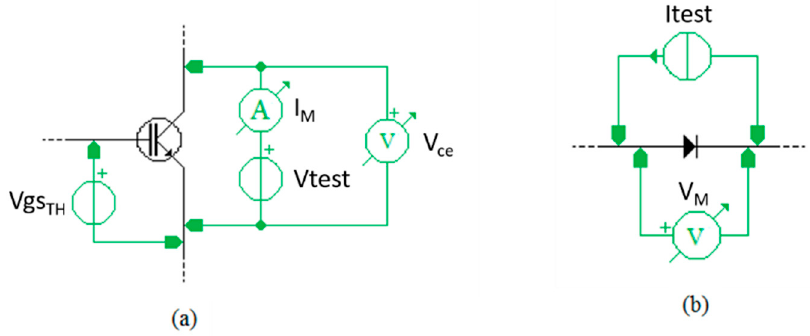
Figure 5. ( a ) In-circuit thermal test for IGBT device; ( b ) in-circuit thermal test for diode device.